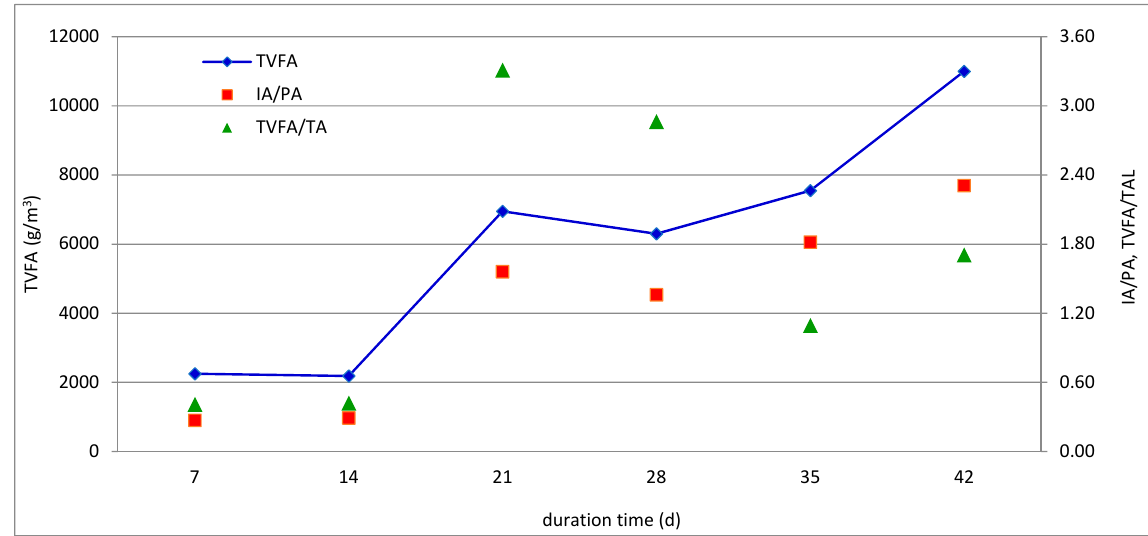
Figure 5. Changes in volatile fatty acids and alkalinity during the semicontinuous anaerobic co-digestion of ASW, IF, and MONG with SRT of 30 days (experiment R-1).